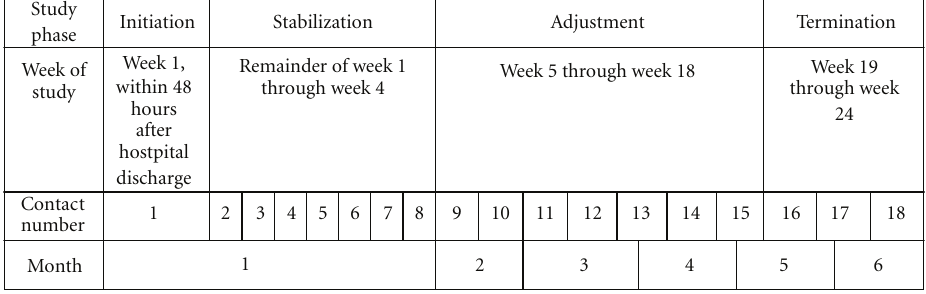
Figure 1: Parent study research phases with corresponding timing and contact